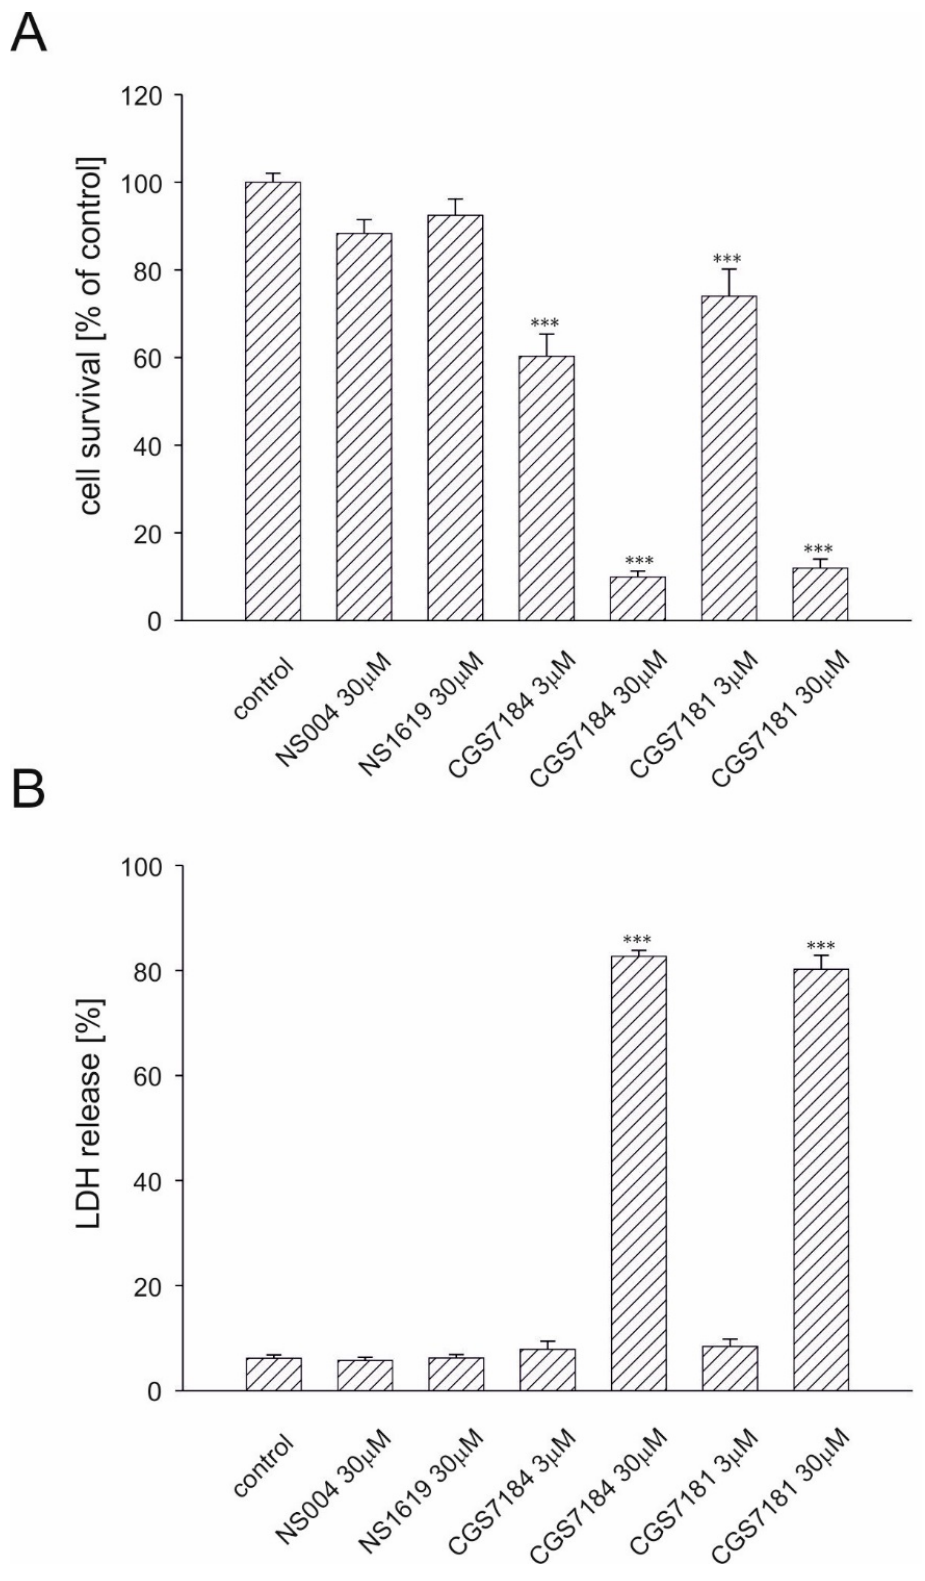
Figure 3. Potassium channel openers CGS7181 and CGS7184 induce HT22 cell death. HT22 cells were treated with potassium channel openers NS1619, NS004, CGS7181, and CGS7184. Cell survival was estimated with the MTT assay ( A ) or by LDH release ( B ) 18 h after insult. All data are expressed as means ± SEM from at least five independent experiments with at least three replicates per data point. *** p < 0.001 by one-way ANOVA followed by Tukey’s test.